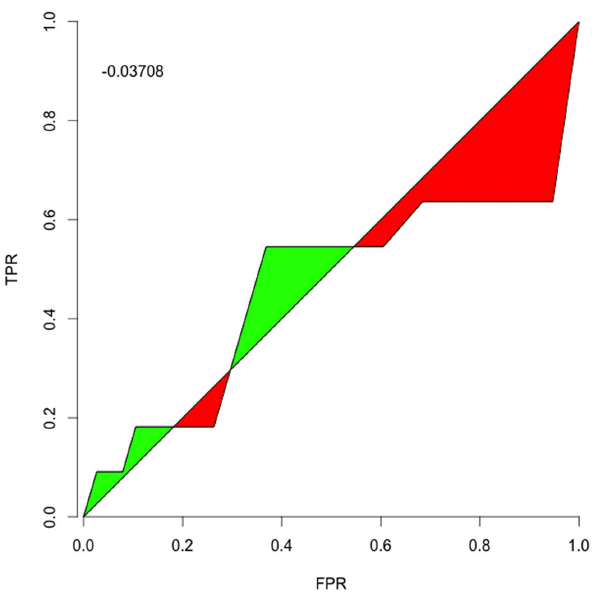
Figure 4. Inhibition Identification. The ROC for identifying the flexible and free inhibition interactions in the yeast cell